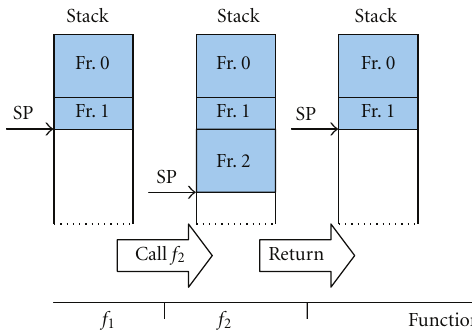
Figure 7: Standard management of the